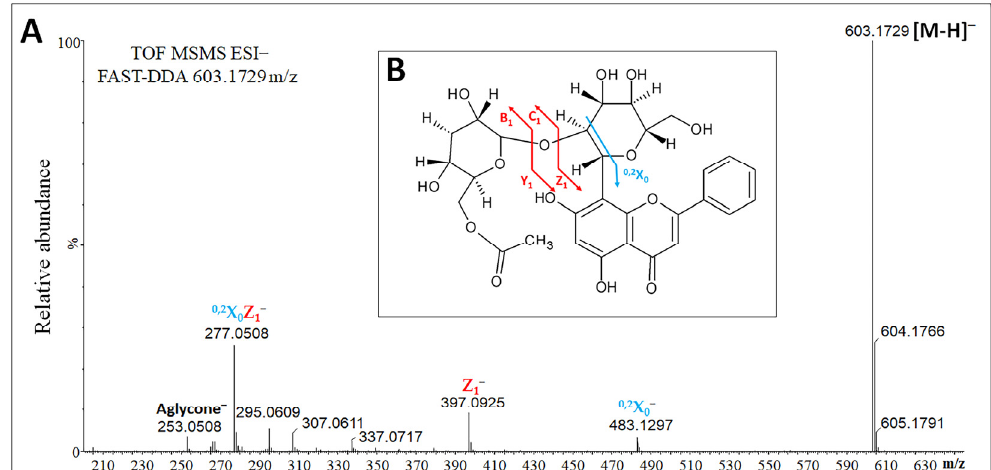
Figure 2. Fragmentation profile and identity of the ion with an m/z value of 603.1729. ( A ) Fragmentation profile determined by FAST-DDA. ( B ) Putative structural annotation as chrysin C-(acetyldeoxyhexosyl) hexoside. Cyan and red arrows indicate the breakage points, giving rise to the diagnostic fragments highlighted by the glycoside fragmentation nomenclature [33].